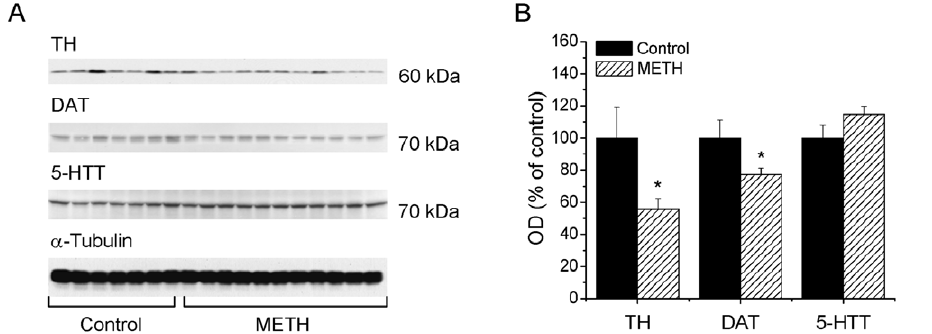
Figure 5. METH self-administration resulted in decreased expression of DAT and TH proteins in the cortex. (A) Immunoblots showing TH, DAT and 5-HTT protein expression in the cortex 14 days after cessation of METH intake. (B) Quantification of METH toxic effects demonstrates significant decreases in TH and DAT, but not in 5-HTT protein levels. Data shown as mean 6 SEM. * p , 0.05; ** p , 0.01 vs control. Data were analyzed by ANOVA followed by PLSD, n=7 2 11 per